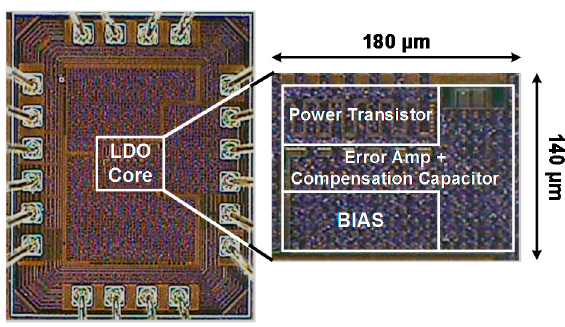
Figure 10. Chip photograph.